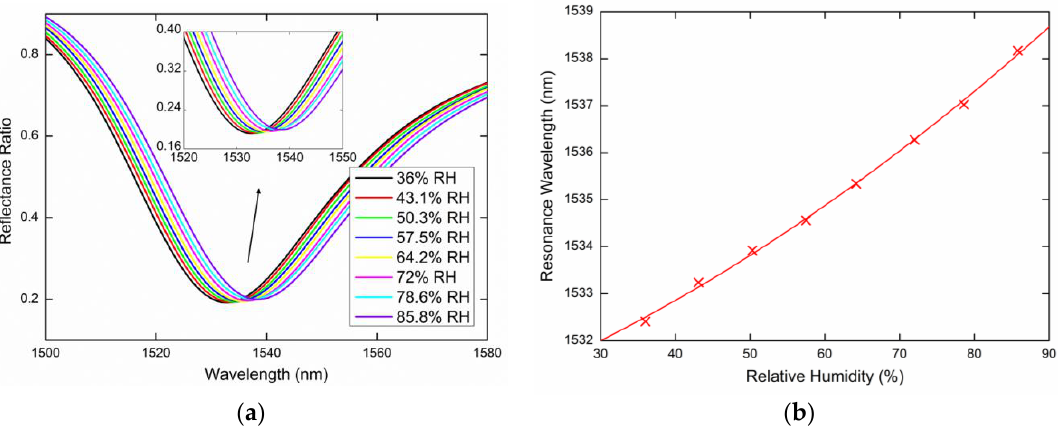
Figure 13. Measured spectral reflectance ratio 𝑅 𝑠 (𝜆) / 𝑅 𝑝 (𝜆) for the external angle of incidence 𝛼 = 20.6° ( a ), the resonance wavelength as a function of the RH with a second-order polynomial fit ( b ).